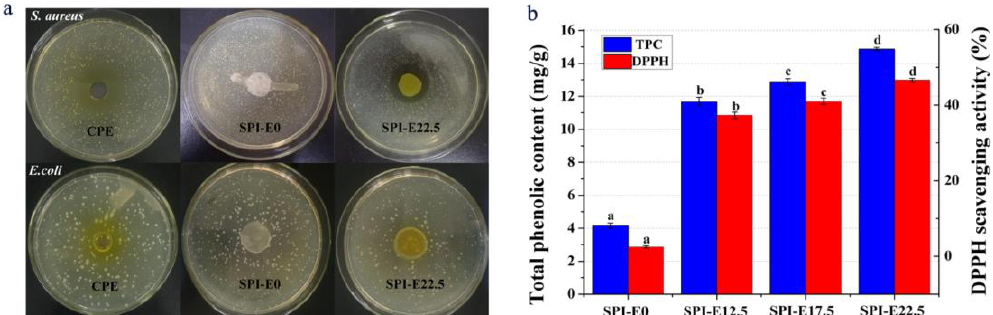
Figure 7. ( a ) The antibacterial activity of the CPE and films; ( b ) antioxidant activity including total phenol content (TPC) and 2,2-diphenylpicrylhydrazyl (DPPH) scavenging activity of the